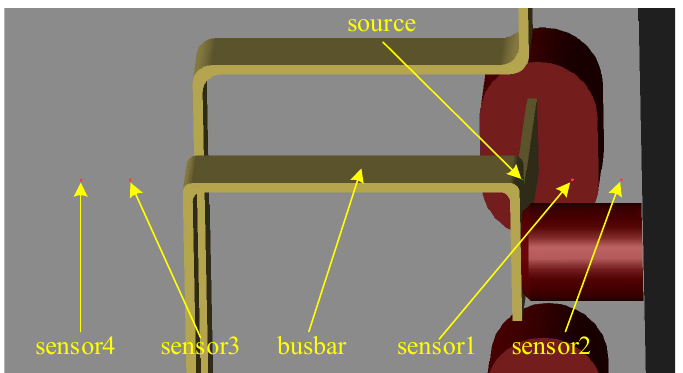
Figure 11. Location distribution of source and point sensors around busbar .